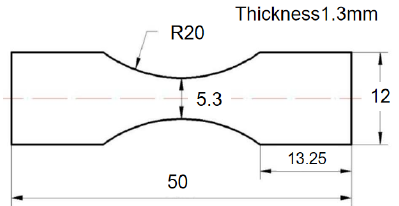
Figure 3. External dimensions of plate specimen (mm).